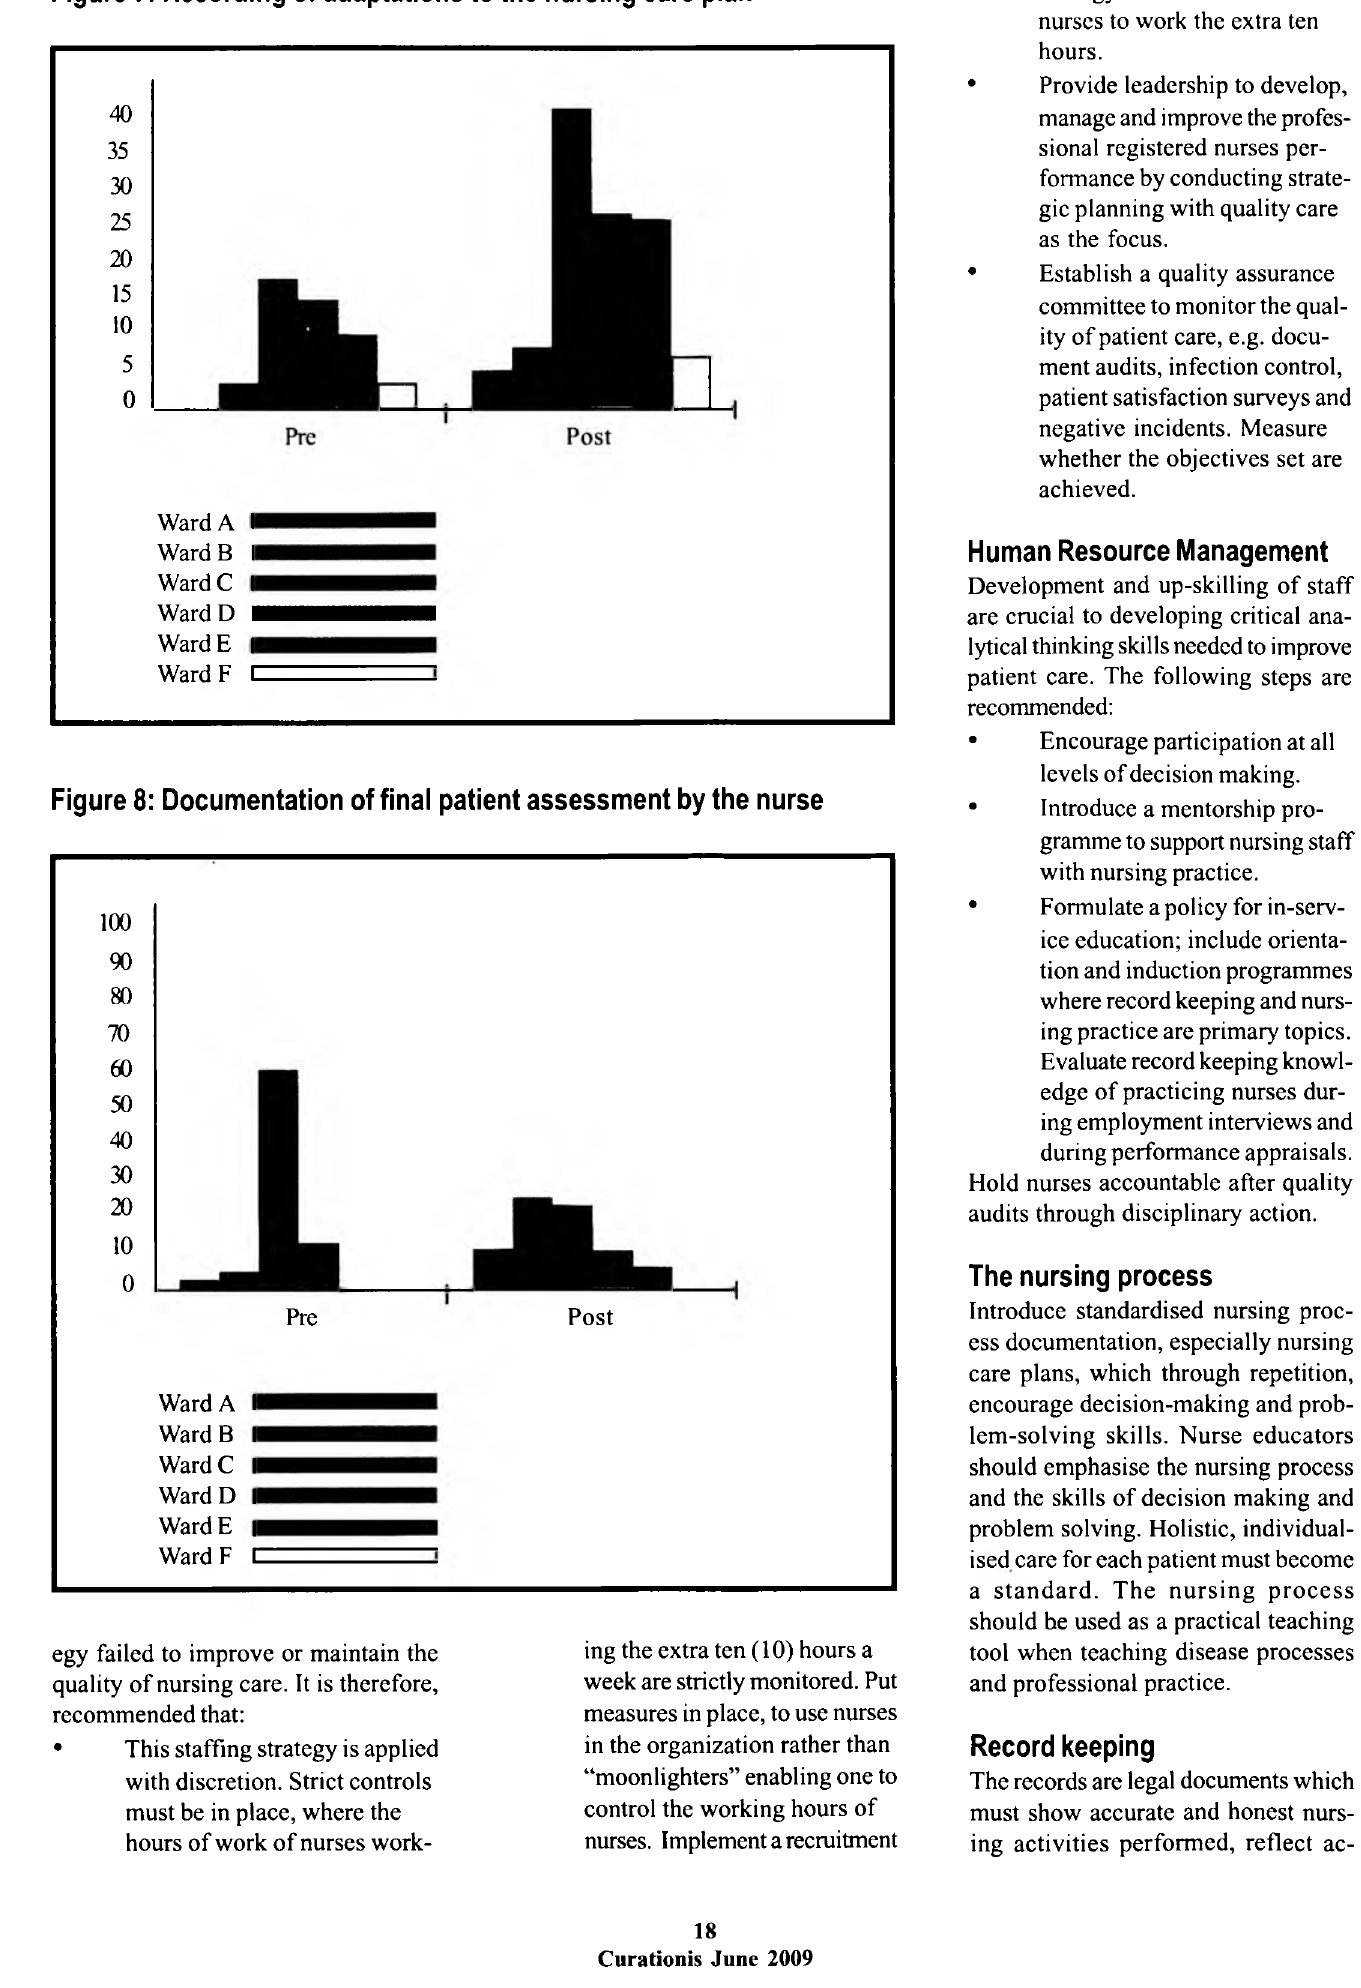
Figure 7: Recording of adaptations to the nursing care plan